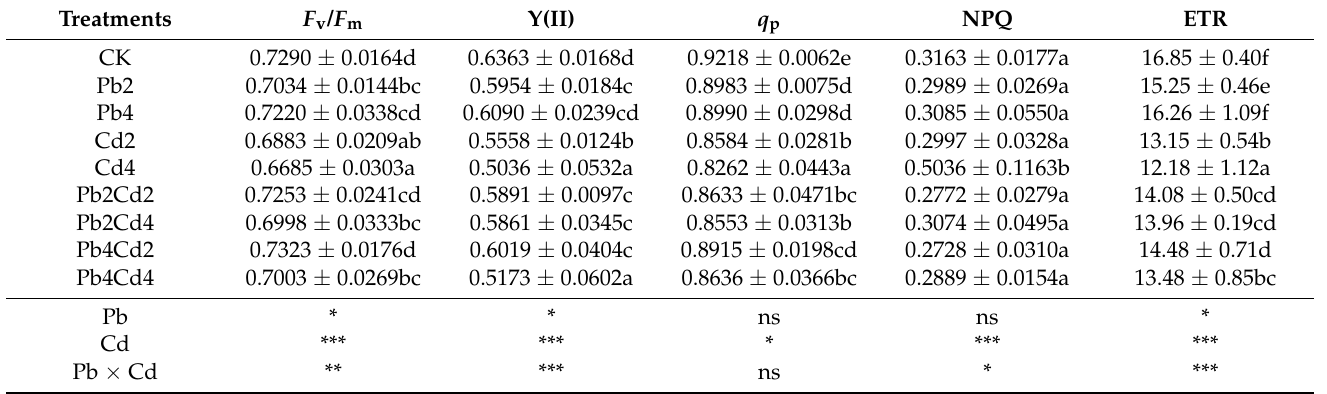
Table 5. Effects of individual and combined Pb and Cd stress on chlorophyll fluorescence parameters in F . parvifolia. The post hoc test used for the estimation of the significance level is the Duncan test. Different lowercase letters in the same column indicate significant differences at p < 0.05. Each value represents mean values ± SEs (n = 5). ns, p > 0.05; *, p < 0.05; **, p < 0.01; ***, p <